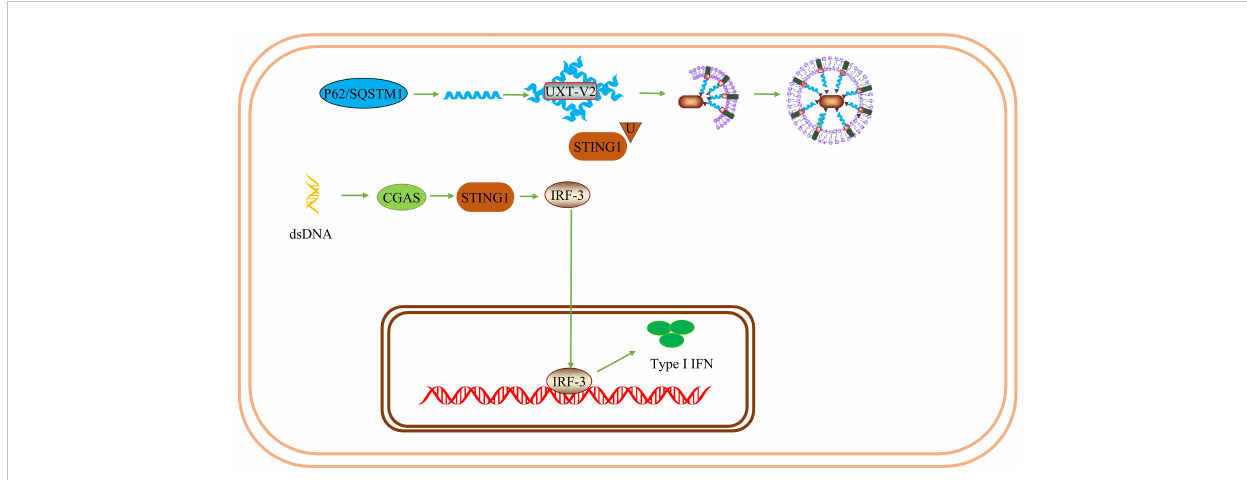
FIGURE 6 UXT inhibits the immune response: UXT-V2 negatively modulates the cGAS-STING1 signaling pathway by promoting the autophagy degradation of STING1 mediated by P62. These changes lead to a down-regulation of the type I IFN